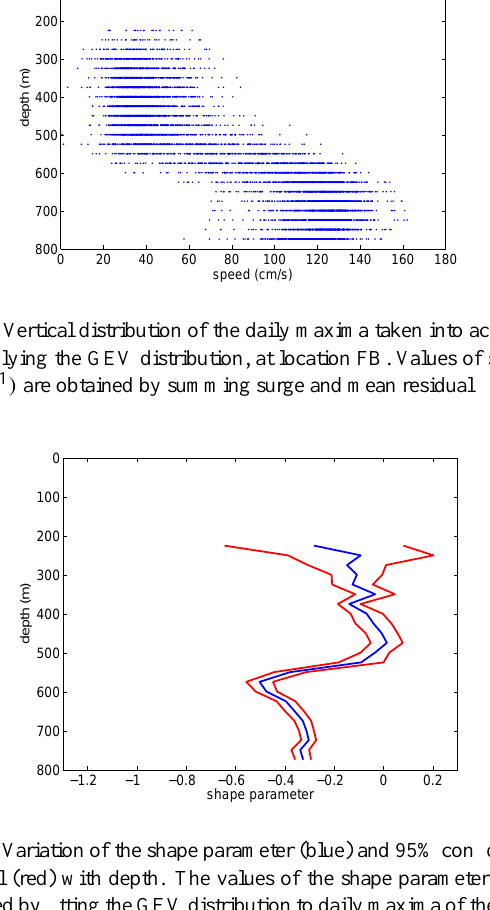
Fig. 7. Return level plot (cms − 1 ) for the sum of surge and mean residual flow at location FB, depths 349, 499 and 649m, from top to bottom. The return period is in